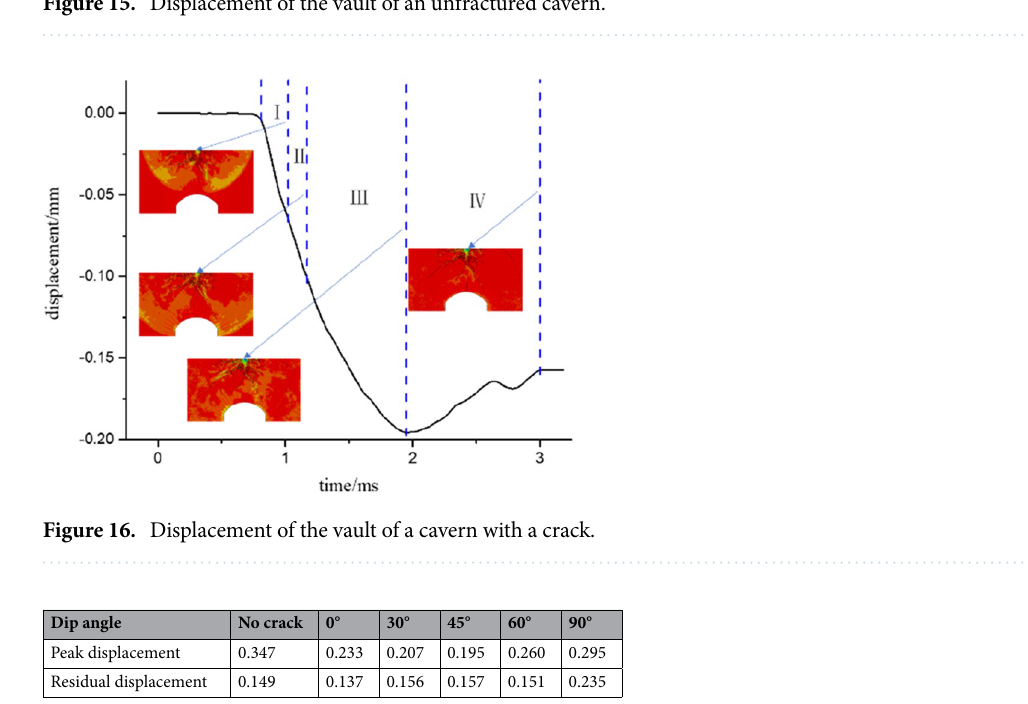
Figure 15. Displacement of the vault of an unfractured cavern.